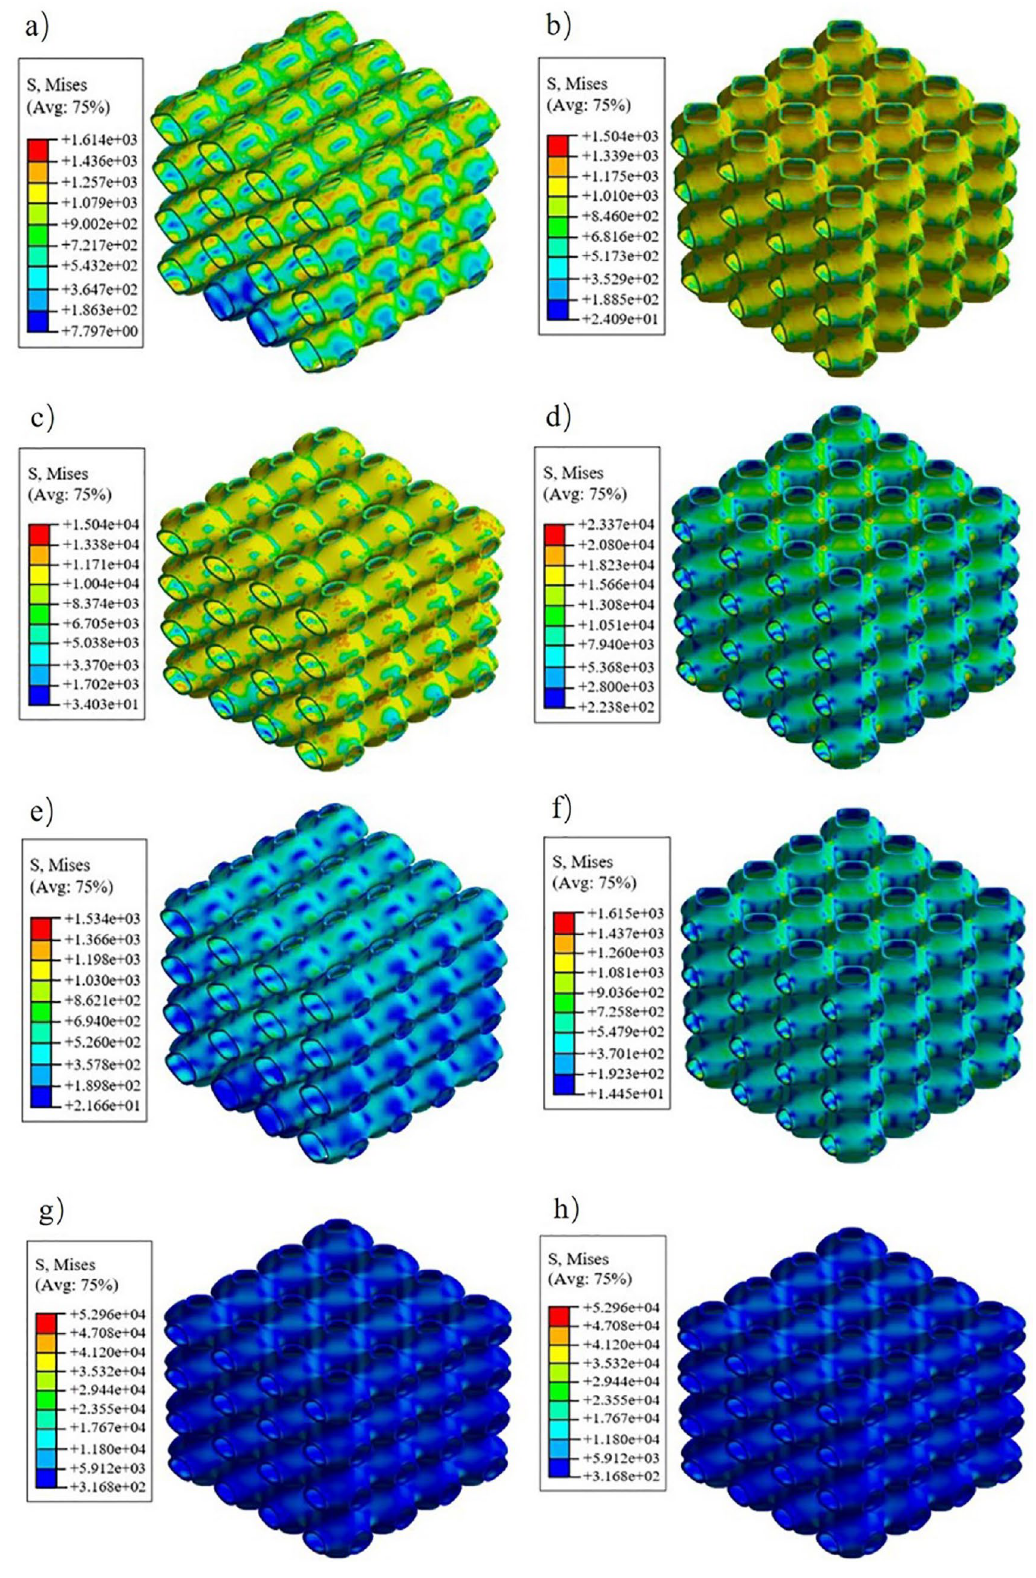
Figure 6. Finite element analysis cloud map: ( a ) the stress distribution of P1-3 scaffolds in Y direction; ( b ) the stress distribution of P1-3 scaffolds in Z direction; ( c ) the stress distribution of P1-2 scaffolds in Y direction; ( d ) the stress distribution of P1-2 scaffolds in Z direction; ( e ) the stress distribution of P2-3 scaffolds in Y direction; ( f ) the stress distribution of P2-3 scaffolds in Z direction; ( g ) the stress distribution of P1-1 scaffolds in Y direction; ( h ) the stress distribution of P1-1 scaffolds in Z